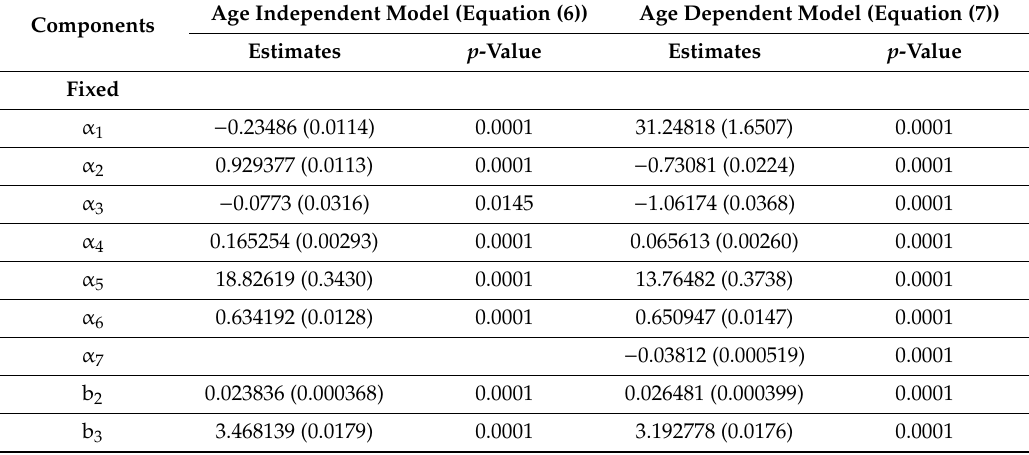
Table 5. Parameter estimates, variance components, and fit statistics of the mixed-e ff ects diameter increment models; R 2 m : marginal coe ffi cient of determination; R 2 c : conditional coe ffi cient